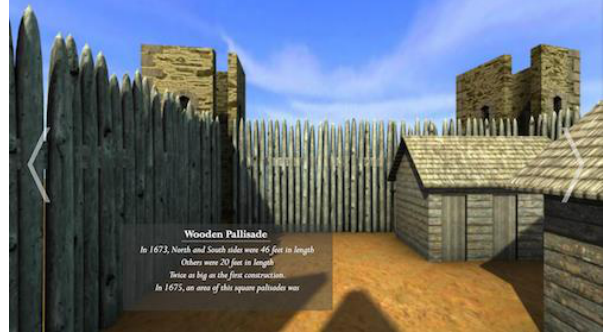
Figure 9: The interactive scenery of the 1675 interior fortress.